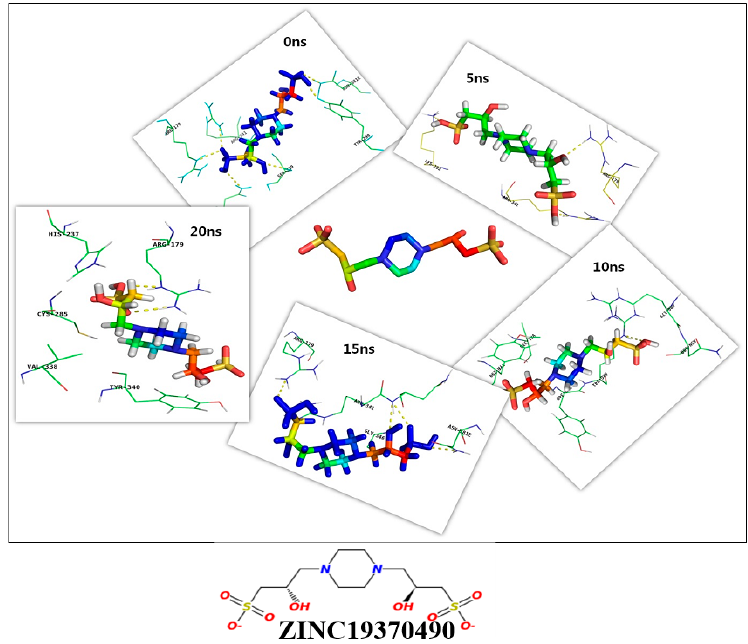
Figure 3. Binding mode of ZINC19370490 with active site residues of caspase 8 at different time intervals.